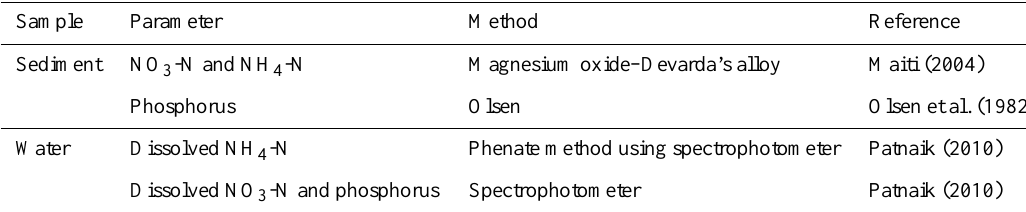
Figure 3. Discharge rating curves for some of the sub-watersheds where Q and H stand for volume in cubic metres per second and flow depth in metres, respectively. Table 2. Methods and procedures used for the chemical analysis of sediment and water